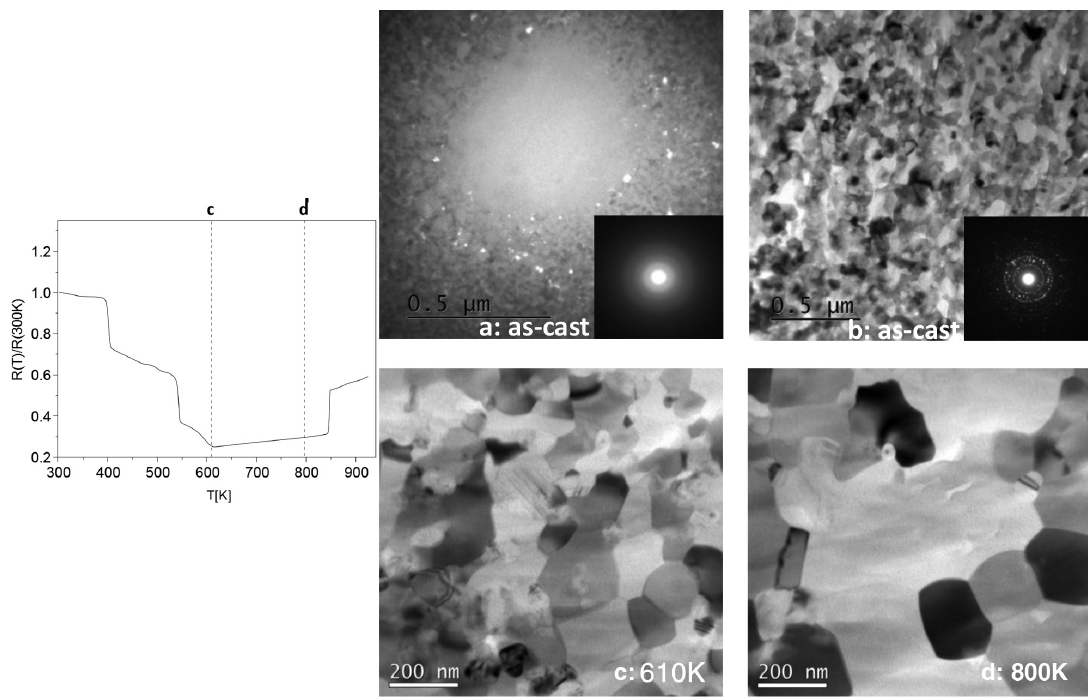
Figure 5. TEM micrographs of Al